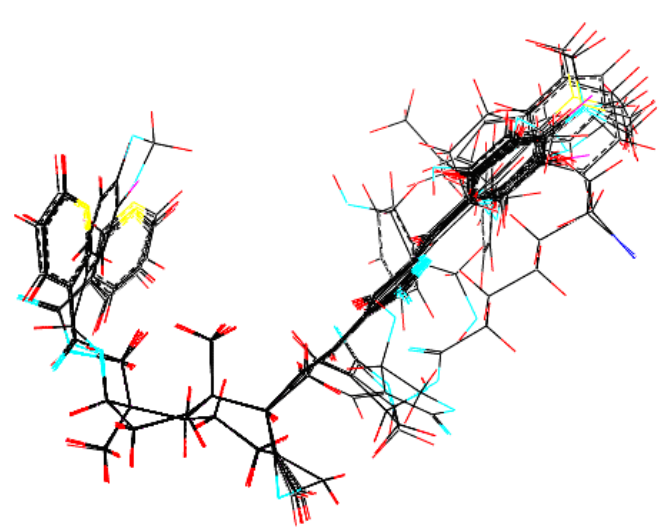
Figure 5. Alignment of the database.